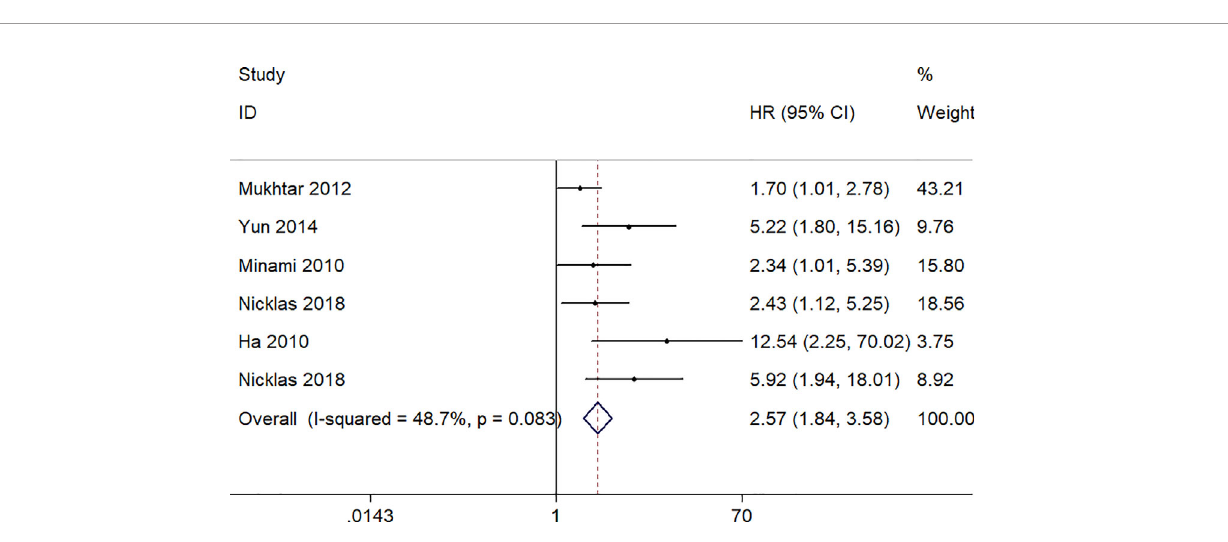
FIGURE 4 | Forest plot of studies evaluating hazard ratios of S100A8 overexpression and the progression-free survival or recurrent-free survival of